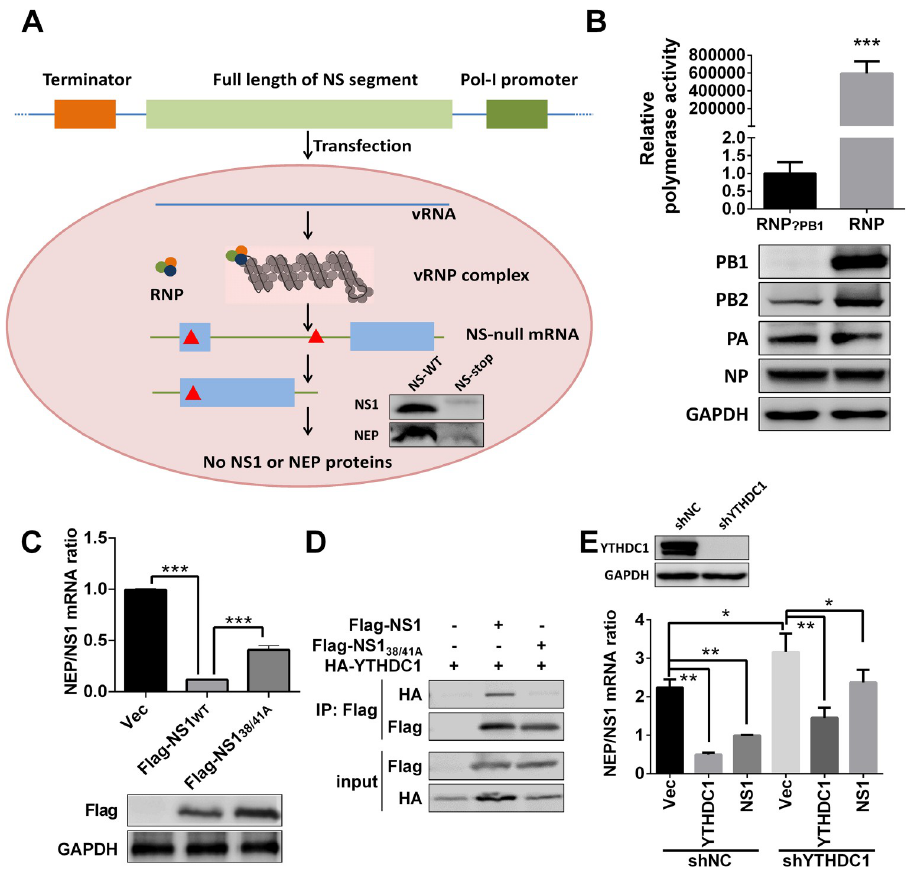
Fig 4. NS1 regulates NS segment splicing through YTHDC1. (A) Schematic illustration of NS-null minigenome system and detection of specific NS mRNAs. Construction of the pHI NS-null plasmid, which contains multiple stop codons (red triangle). Primers used for NS-null mRNA detection are shown as blue arrowheads. 3P (PA, PB1, PB2). NS-null (two stop codons were mutated at positions 45 and 456, with transcription but not translation). (B) HEK293T cells were transfected with the indicated viral RNP reconstitution plasmids (pCDNA-3.1-PB1, -PB2, -PA, and -NP, pPolI-Luc, and Renilla); polymerase activity was measured at 24 h post transfection. Data are presented as the average of three experiments and error bars indicate the standard error of the mean (SEM) (Student t-test; *** , P < 0.001). (C) HEK293T cells were transfected with the minigenome system and Flag-NS1 or Flag-NS1 38/41A for 24 h, total RNAs were extracted and quantified by RT-qPCR with specific primers, and NEP/NS1 mRNA was calculated. Data are presented as the average of three experiments and error bars indicate the standard error of the mean (SEM) (one-way ANOVA; *** , P < 0.001). (D) HEK293T cells were transfected with the indicated plasmids for 24 h. CoIP assay was performed using an anti-Flag antibody and analyzed by western blotting. (E) YTHDC1 was knocked down by shRNA on HEK293T cells. And indicated plasmids were transfected with the minigenome system, and related NEP/NS1 ratios were detected at 24 hours post transfection. Data are presented as the average of three experiments and error bars indicate the standard error of the mean (SEM) (one-way ANOVA; * , P < 0.05; ** , P <